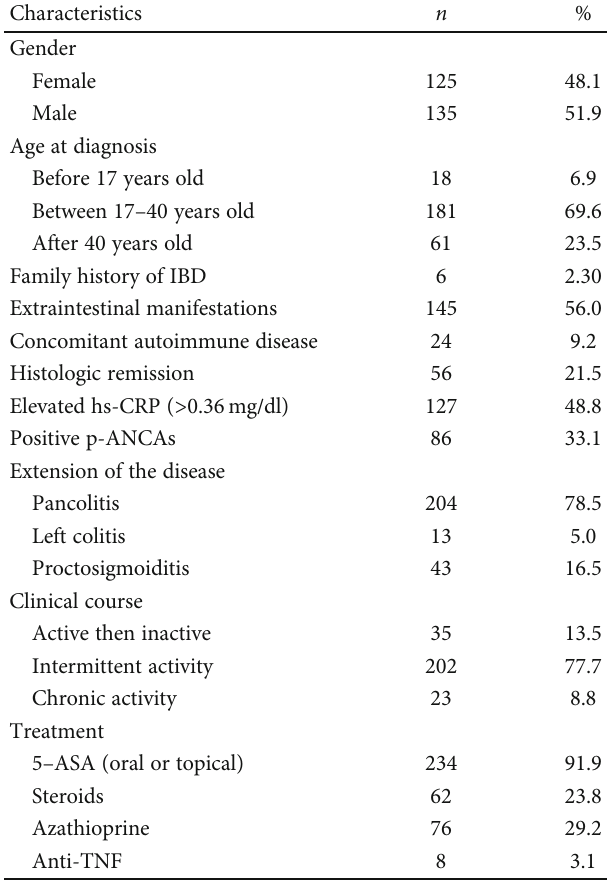
Table 1: Clinical and demographic characteristics of patients with ulcerative colitis ( n = 260